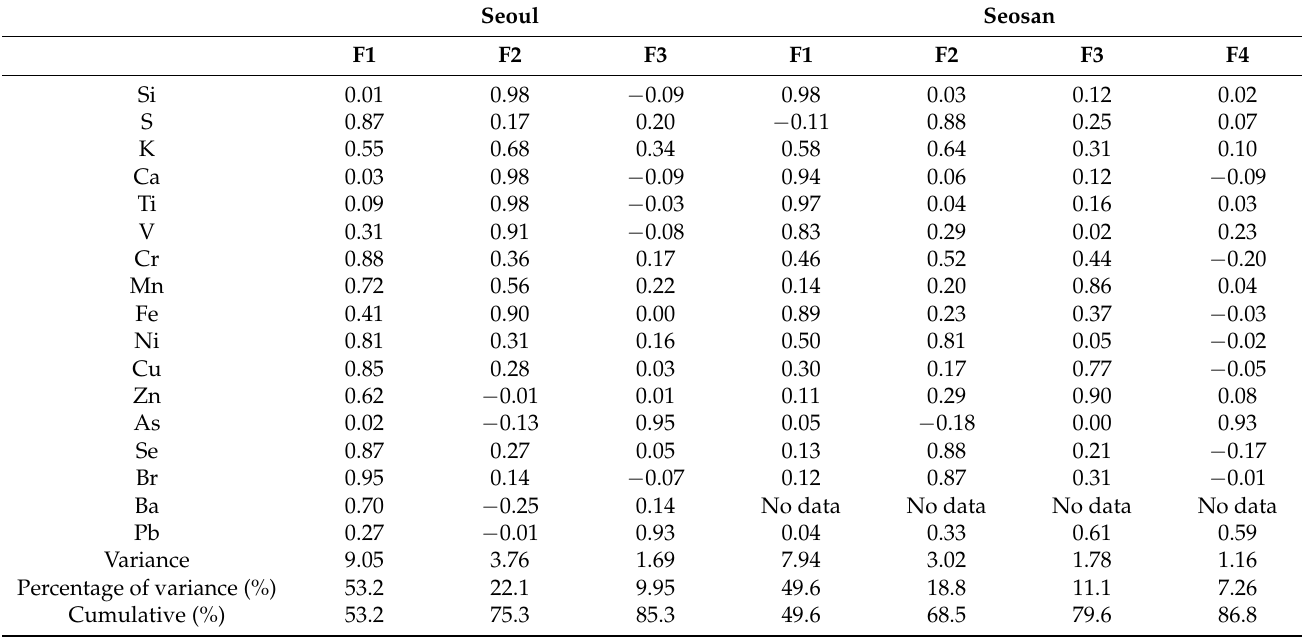
Table 2. Varimax-rotated principal factor (F) loadings for PM 2.5 -bound trace elements at the Seoul and Seosan sites during the winter period.